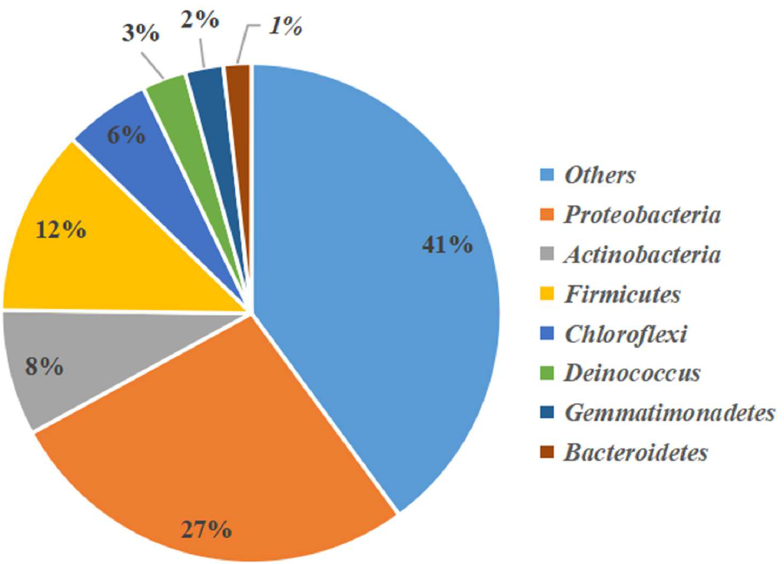
Figure 2. Pie chart showing the percentage relative abundance of the phyla in bacterial communities from samples analyzed by high-throughput sequencing.